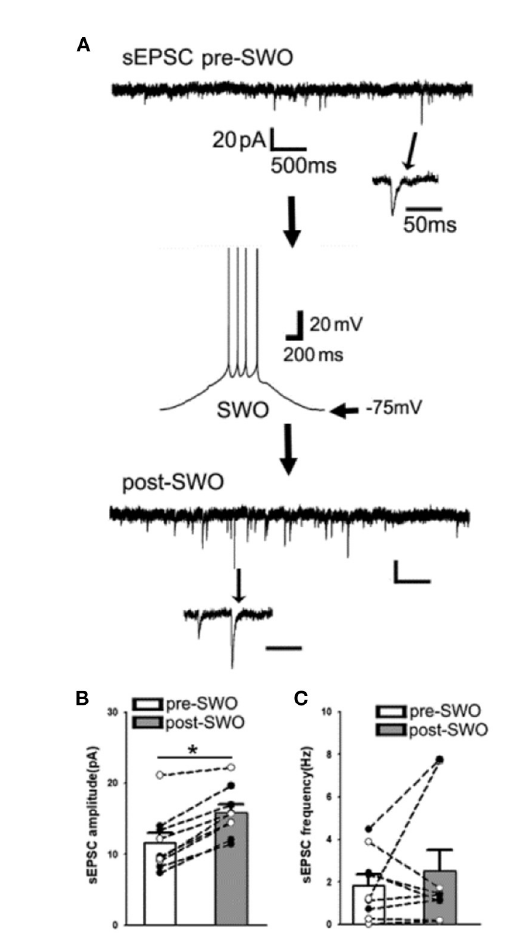
FIGURE2 Artificial SWO induction potentiates spontaneous excitatory synaptic currents (sEPSCs) in layer V cortical neurons. (A) Shows one representative pre-SWO (top) and post-SWO sEPSC (below) in layer V cortical neurons and the middle panel shows one SWO. Individual sEPSC events (with arrow indicating) are expanded in a small temporal scale. Scale bars are indicated as labeled. (B) Shows the summary data of pre- (empty bar) and post-SWO (gray bar) sEPSC amplitudes from the same cortical neurons (dots connected with one line). (C) Shows the summary data of pre- (empty bar) and post-SWO (gray bar) sEPSC frequencies from the same cortical neurons (dots connected with one line). *Indicates a significant difference p < 0.05.